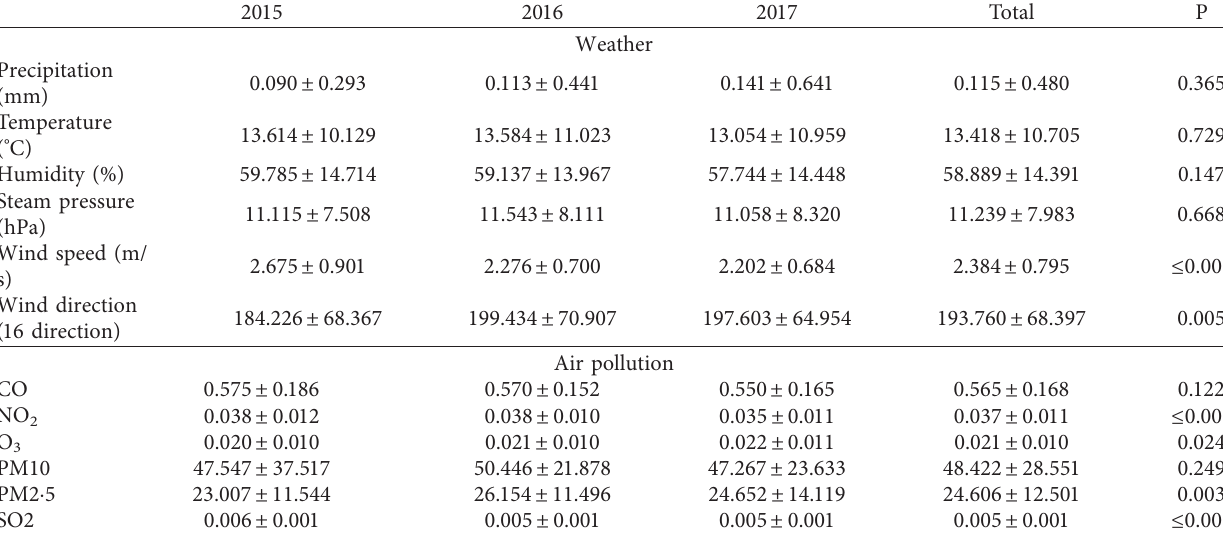
Table 3: General information of atmospheric variables (Mean ±